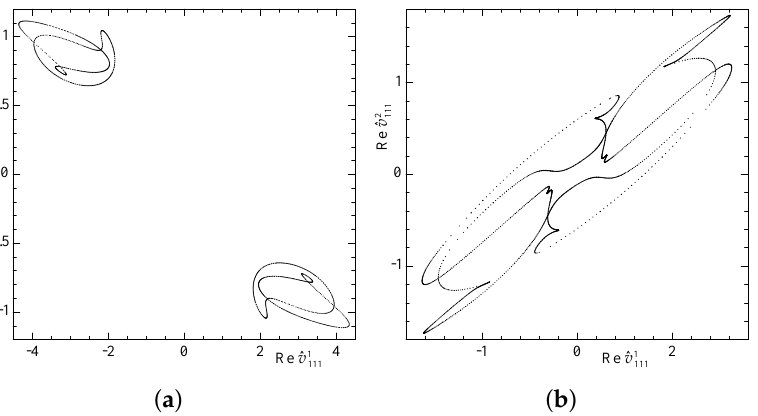
= 0 on the plane (Re ˆ v 1 , Re ˆ v 2 ) 222 111 111